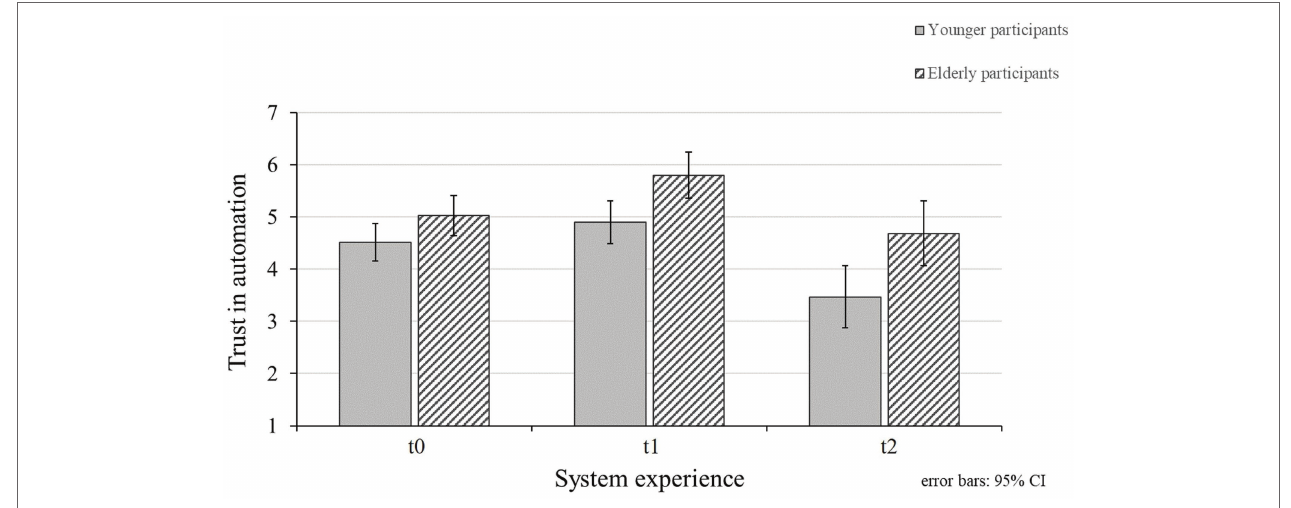
FIGURE 5 | Mean values for younger and elderly participants’ trust in the eHMI for the points of measurement (t0 = initial measurement; t1 = valid system functions; and t2 = valid and invalid system functions). Higher values represent higher trust